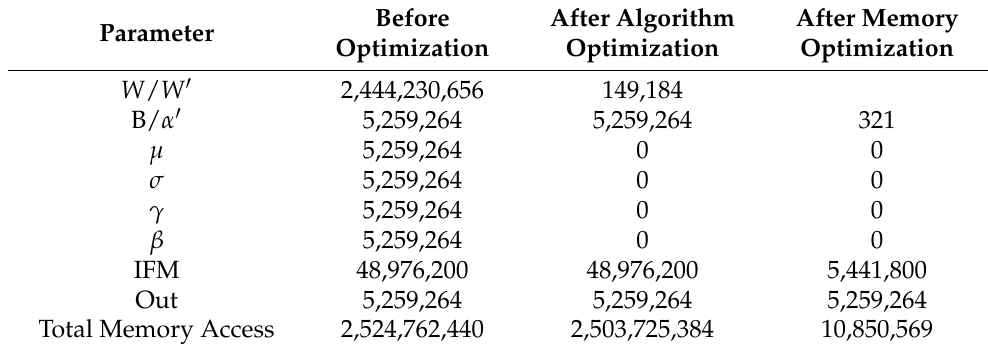
Table 4. Memory access after and before algorithm optimization, after memory